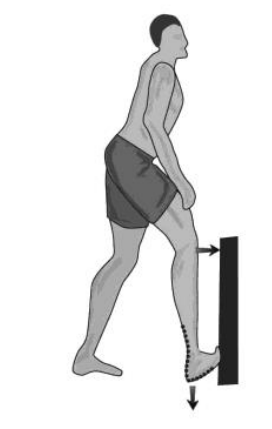
Figure 2. Calf muscle stretching exercise 1.